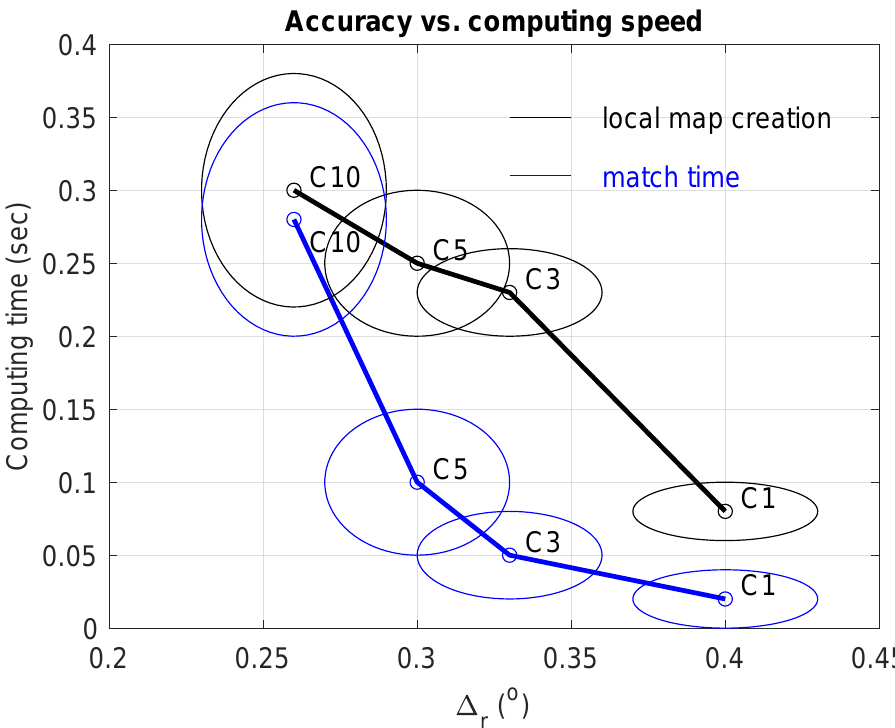
Figure 10. Dependency of the rotational accuracy and computation time on the choice of the number of aggregated frames. Both the local map creation time (black) and the similarity matching time (blue) are depicted. Number of frames ranges from 1 to 10 (C1, C3, C5, C10). Ellipses represent the 2 s.t.d. of the